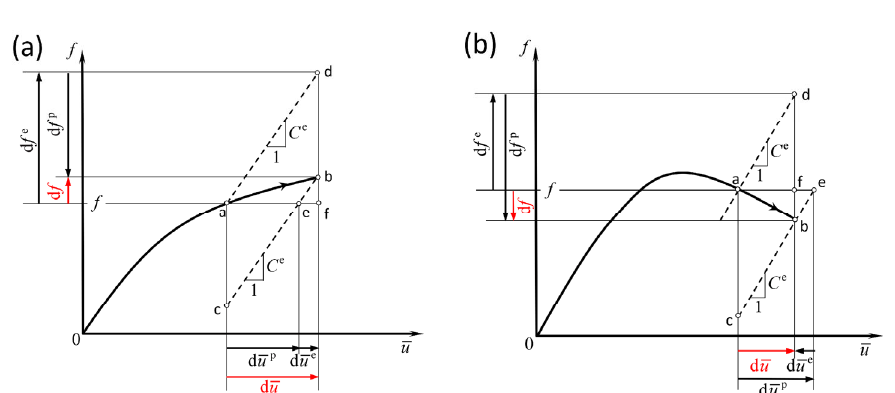
Fig. 2 Schematic diagram of the relation between the elastic stress increment e d f and the plastic relaxation stress increment p d f : (a) hardening process; and (b) softening